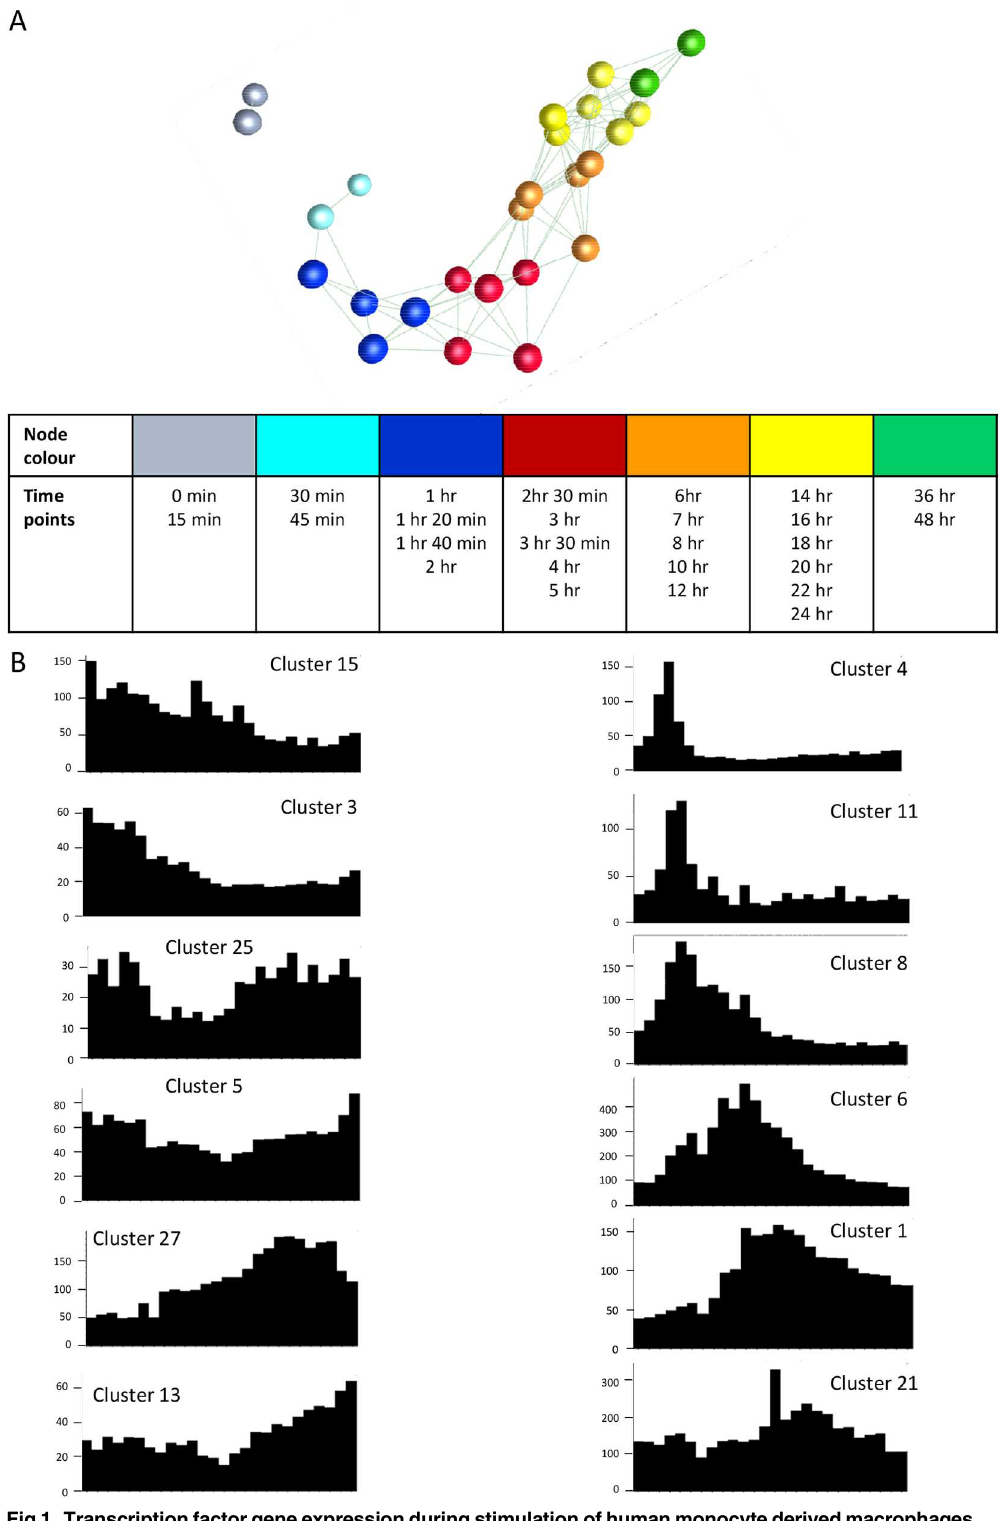
Fig 1. Transcription factor gene expression during stimulation of human monocyte derived macrophages by LPS. A . Sample-based networkof transcription factor geneexpression . Gene-based expression levelsfor all of the annotatedtranscriptionfactors in the humangenome[34]were extracted from the FANTOM5 data and